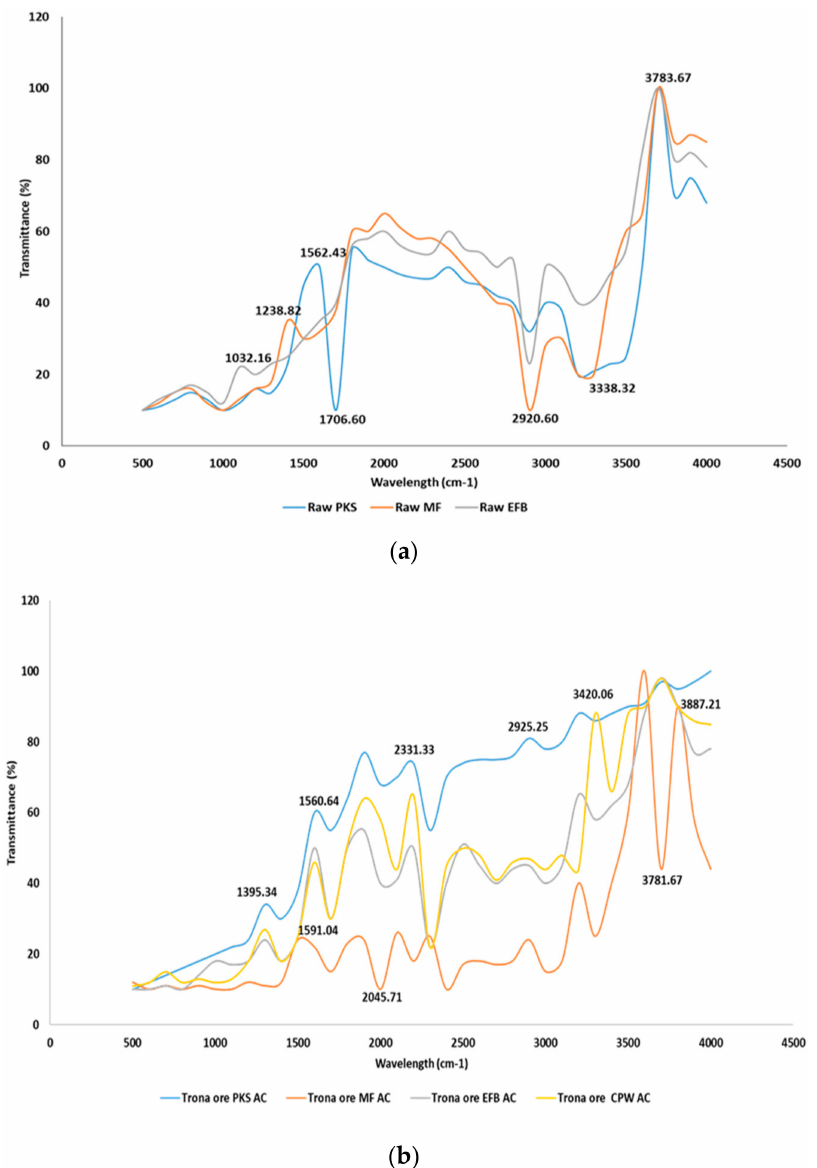
Figure 4. FTIR of OPW from di ff erent processing methods and activation conditions ( a ) raw feedstock ( b ) trona ore activated